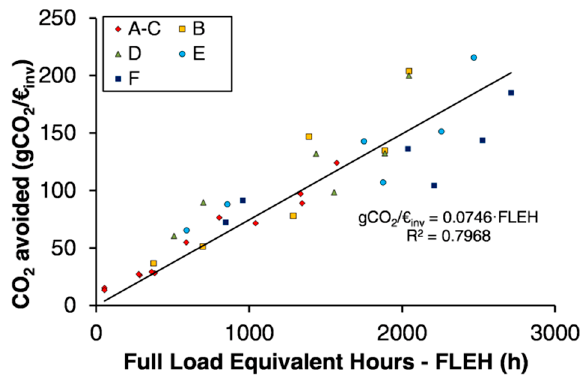
Figure 11. GHG reduction effectiveness of GCHPs in Italy, expressed as CO 2 avoided emissions per euro spent, plotted against the system Full Load Equivalent Hours (FLEH) of operation. The dots, representing every GCHP simulated, are provided with a color code which identifies the specific climate zone (A–F).